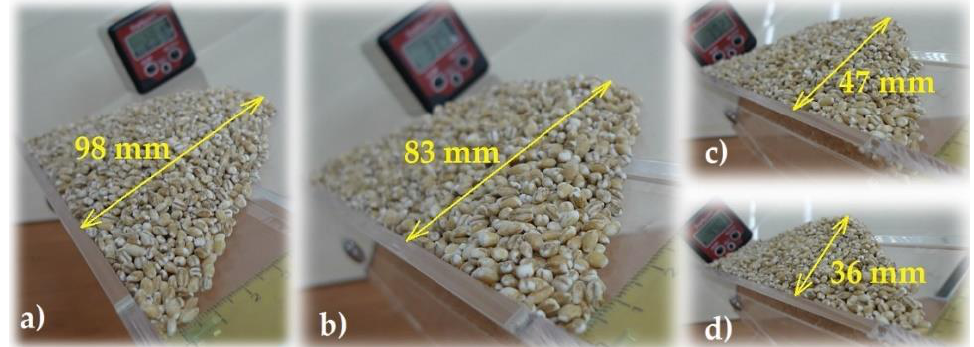
Figure 12. Batch volume V i [cm 3 ] of barley groats spread on the surface of the conveyor belt at H 1 = 15 mm. Length of the distribution z (x) for ( δ – Θ ) (deg) ( a ) 10 deg, ( b ) 15 deg, ( c ) 20 deg and ( d ) 25 deg.